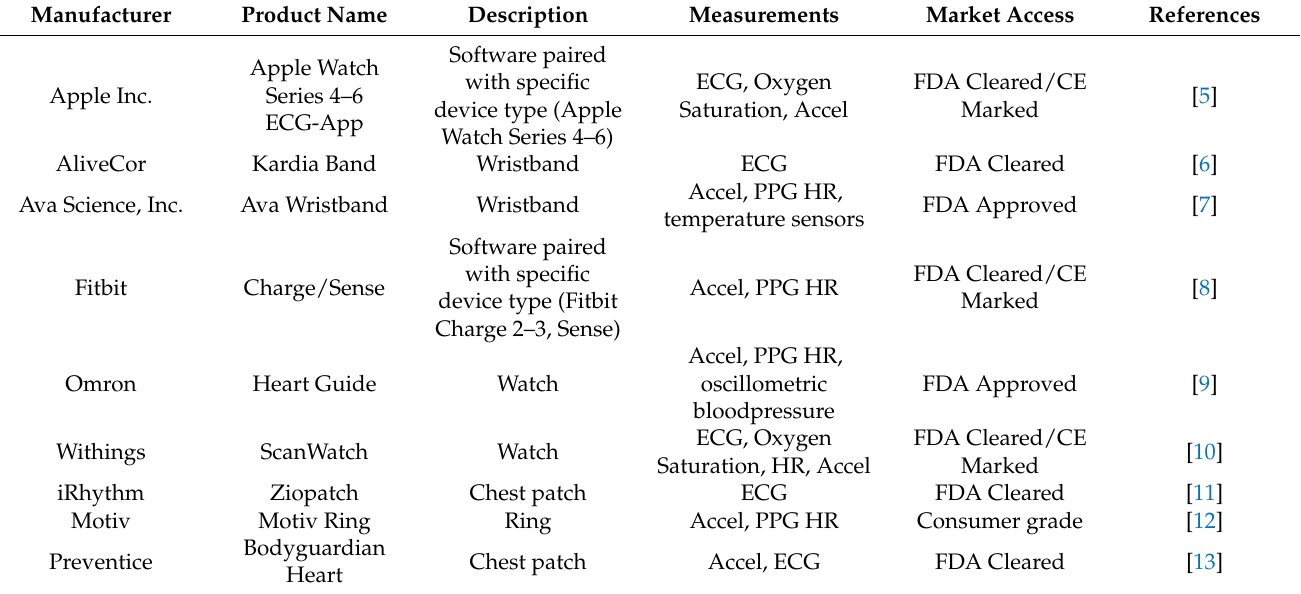
Table 1. Examples of consumer, clinical, and research-grade wearable devices.